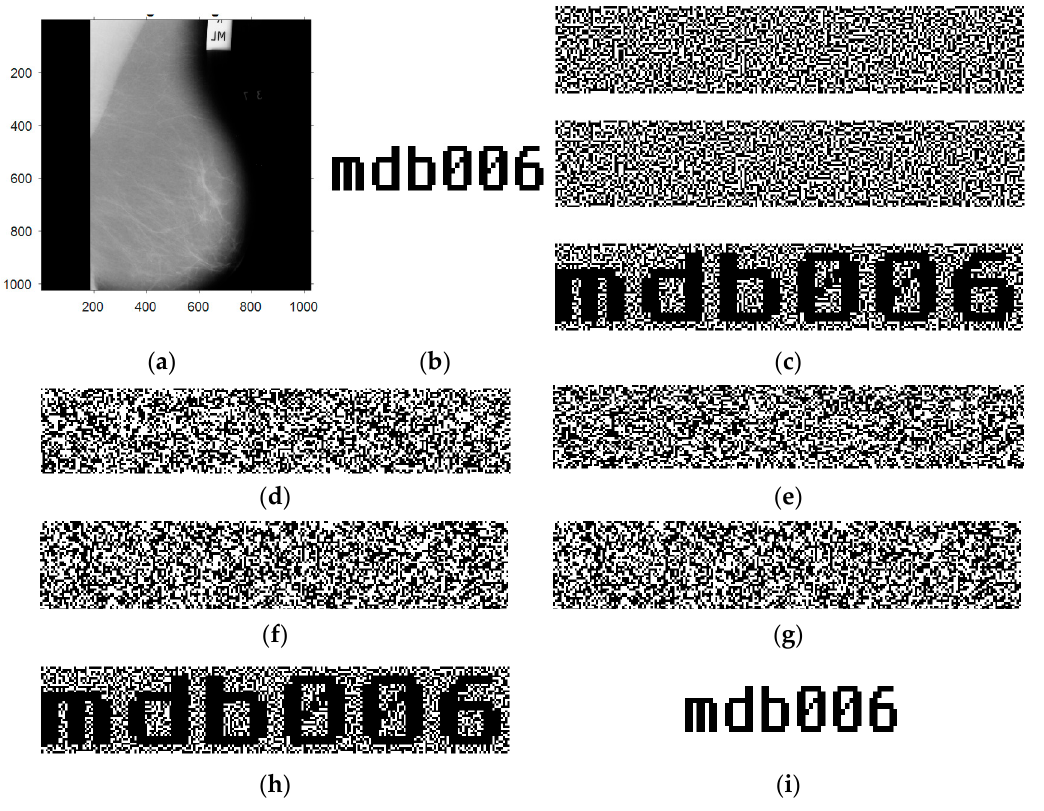
Figure 10. Identity insertion and retrieval for patient mdb006. ( a ) Original mammogram. ( b ) Patient’s ID ( I) . ( c ) Secret shares S 1 and S 2 of I and revealing I after overlapping. ( d ) Embedded secret shares 1 ( W S 1 ). ( e ) Embedded secret shares 2 ( W S 2 ). ( f ) Retrieved secret share 1 ( rS 1 ). ( g ) Retrieved